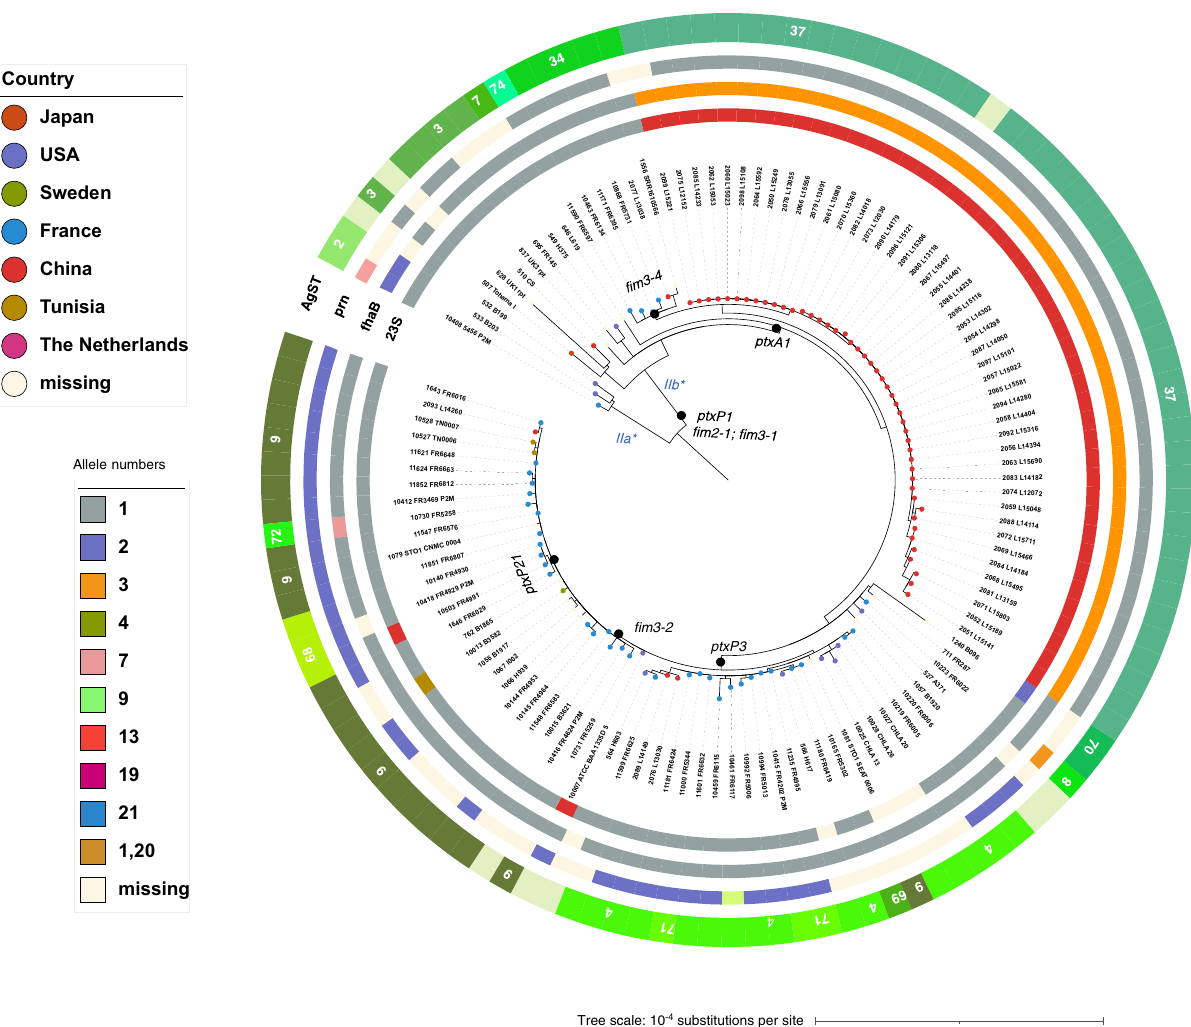
Tree scale: 10 -4 substitutions per Fig. 3 Phylogenetic analysis of Bordetella pertussis . The phylogenetic tree was obtained based on the recombination-purged concatenated multiple sequence alignments of the 2038 core genome loci of the cgMLST_pertussis scheme. The distribution of macrolide resistance is indicated. The three outer circles represent (from innermost): 23S_rRNA alleles, fhaB alleles, prn alleles and the vaccine antigen sequence types (AgST). Lineages IIa and IIb were de fi ned in Bart et al. 2014 and are labelled in blue. An interactive iTOL version of the tree can be accessed at: https://itol.embl.de/shared/ 1l7Fw0AvKOoCF. Source data are provided as a Source Data fi